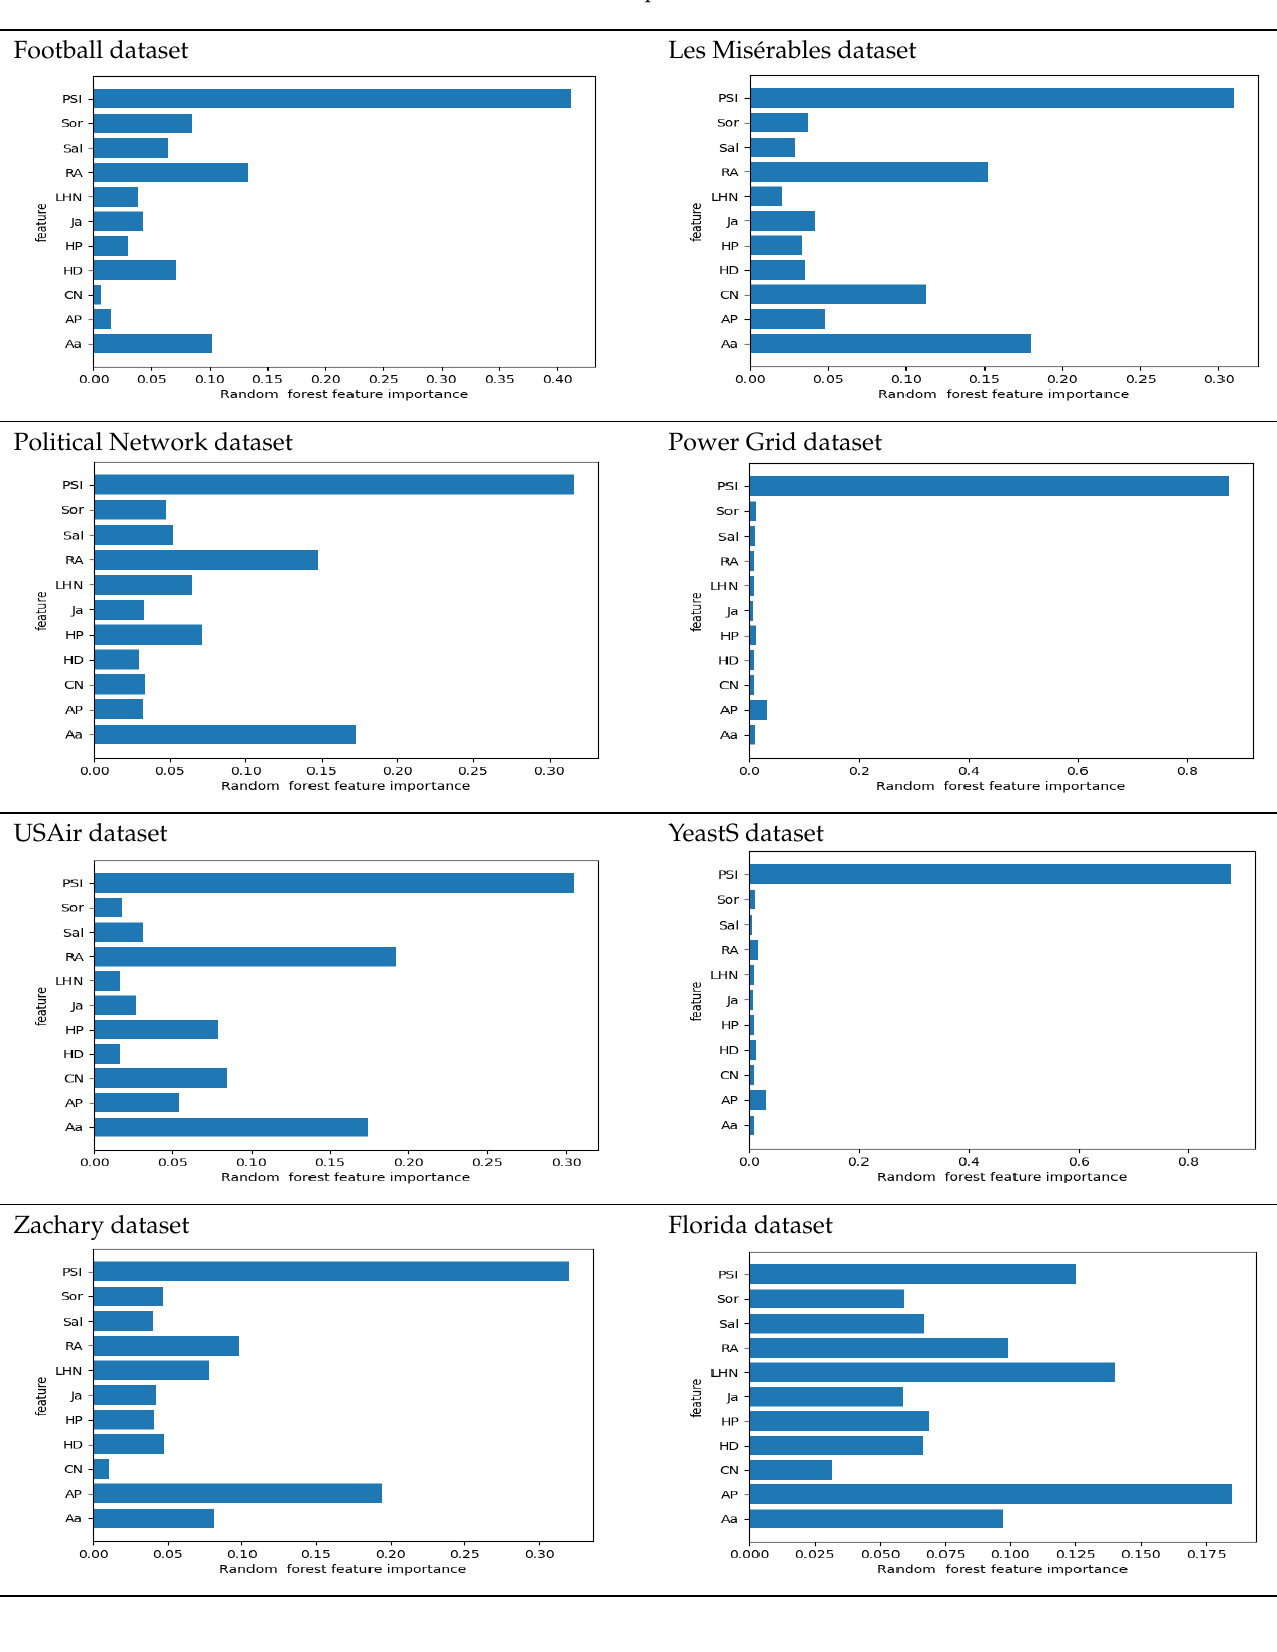
Table 9. Random forest feature